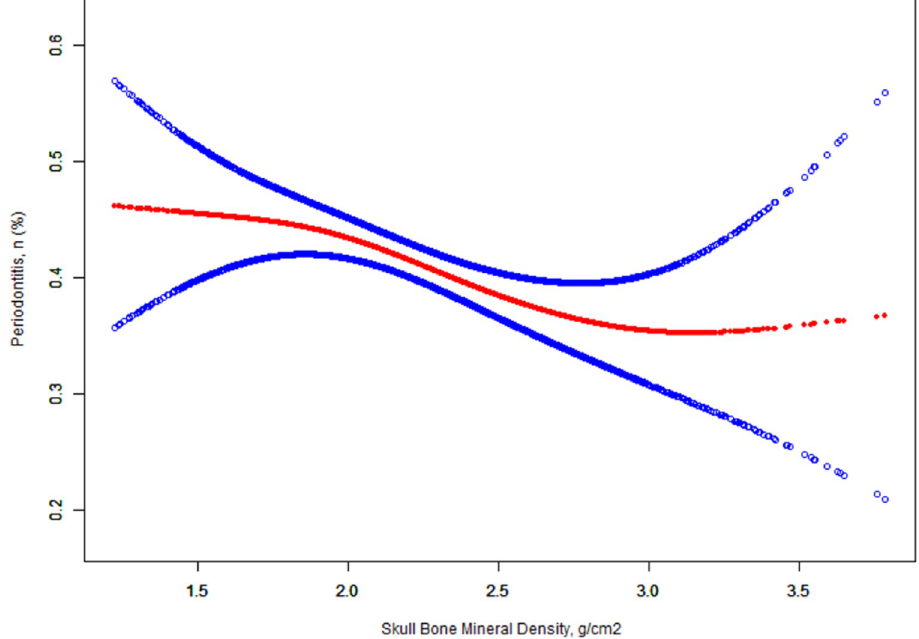
Fig 1. Dose-response relationship between skull BMD and periodontitis � . Solid lines represent smooth curve fitting between variables. The dotted line represents 95 of the fitted confidence interval. � Adjusted for sex; age(smooth); race; education level; PIR; BMI; handgrip strength; smoke consumption; alcohol consumption; hypertension; hypertriglyceridemia; diabetes; general health condition; depressive symptoms; hours of sleep; frequency of interdental hygiene (last 7